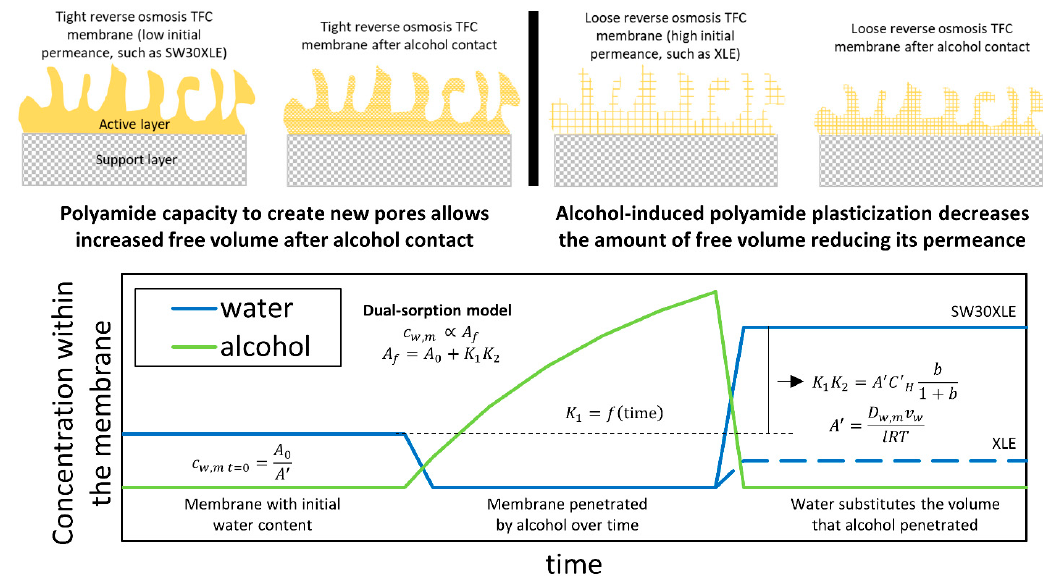
Figure 10. Schematic of the proposed change in tight and loose polyamide layers after contact with short chain alcohols. ( Top ) A comparison of the effect of alcohol contact between a tight and a loose TFC RO membranes. ( Bottom ) A representation of a three-stage mechanism that leads to changes in water permeance after alcohol contact.